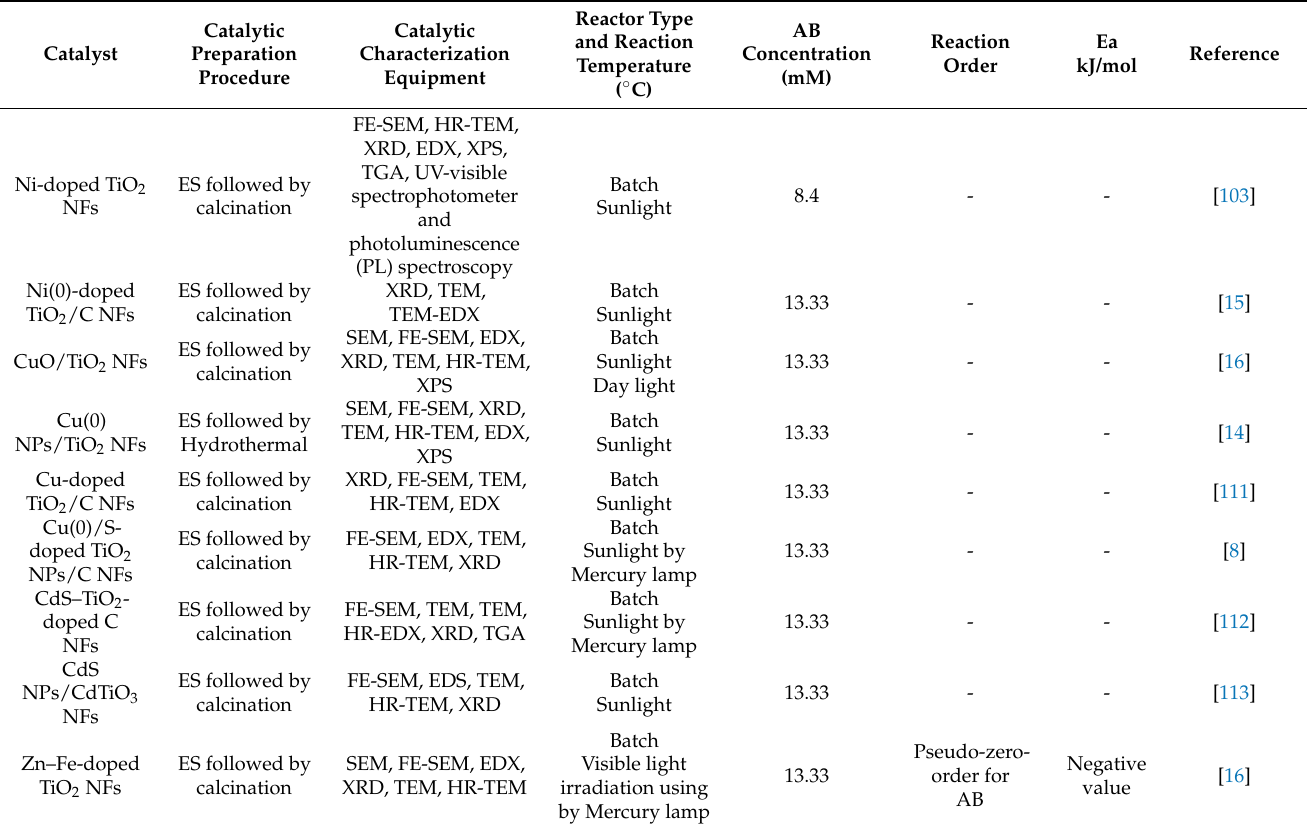
Table 4. Photocatalytic data of metal/metal oxide NP-supported TiO 2 NFs for AB